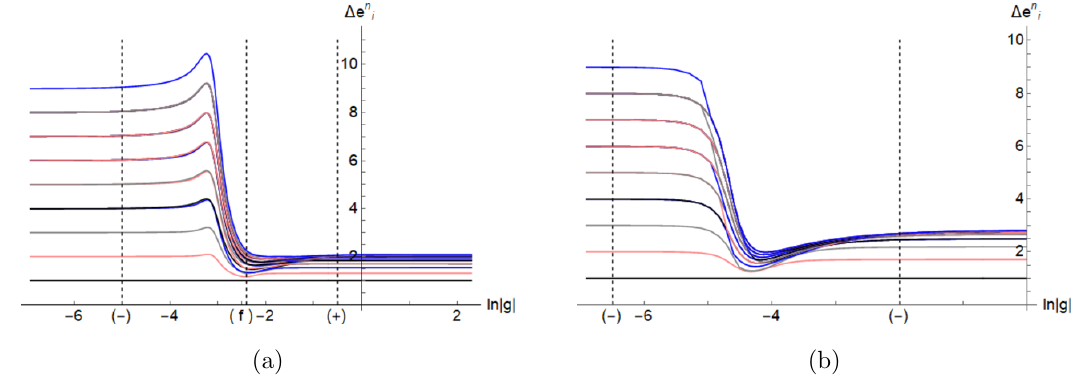
Figure 18. (a) Perturbation of NS fermions by T and the quartic operator with positive g and + (cid:17) chosen in (4.31); (b) Perturbation of NS fermions by T and the quartic operator with positive g and (cid:0) (cid:17) chosen in (4.31).